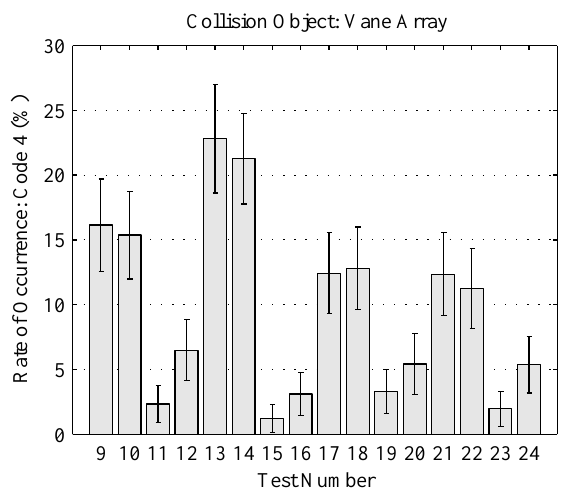
Figure 13. Collision rate (Code 4) with vane array.